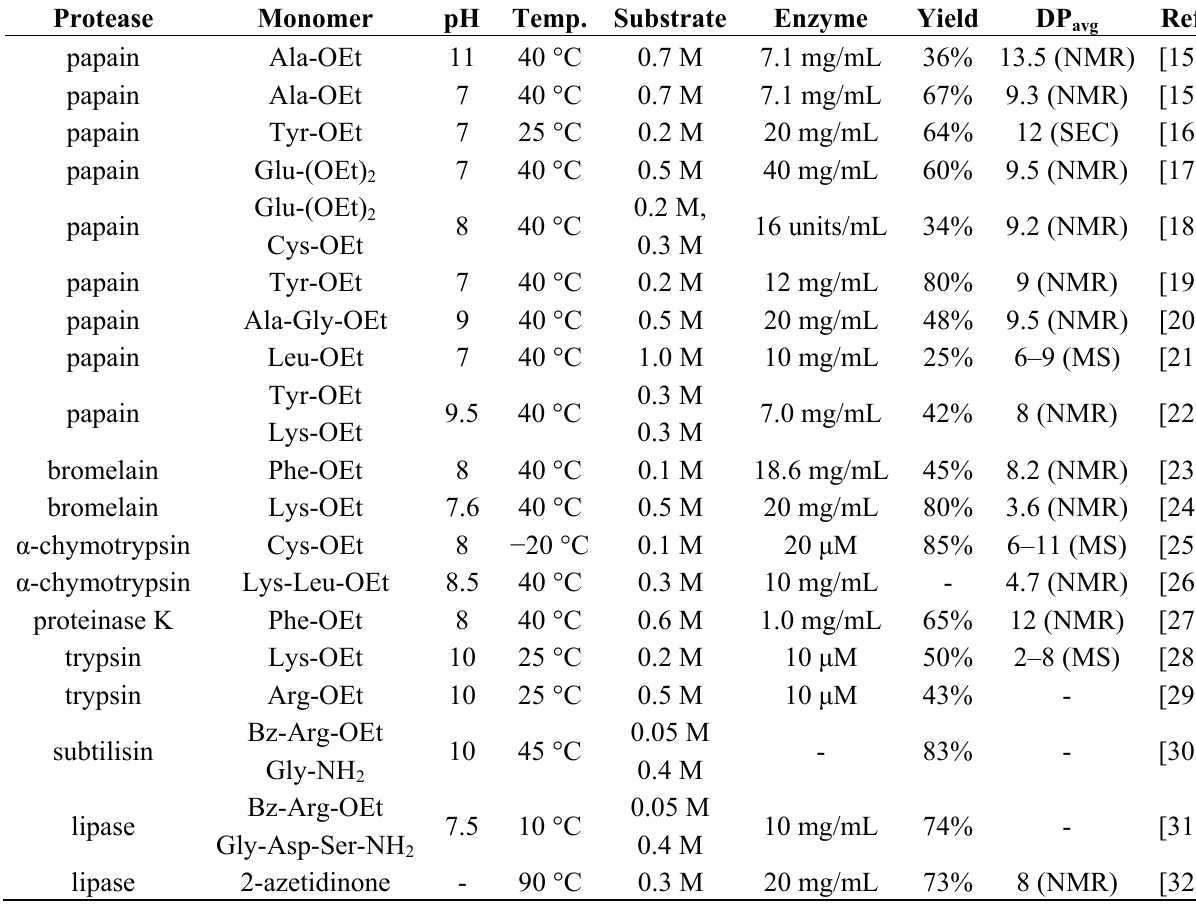
Table 1. Chemoenzymatic peptide